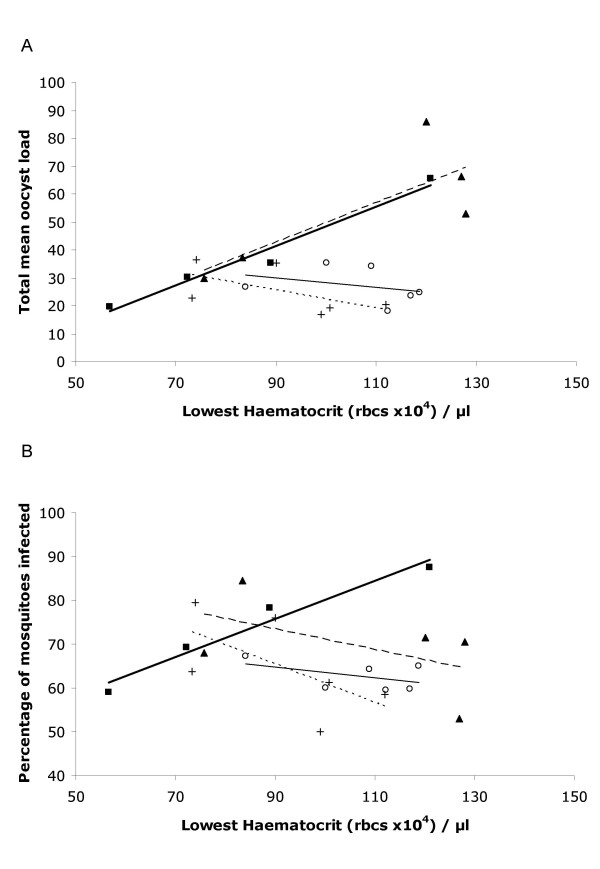
Comparison of lifetime transmission success with peak anaemia. Lifetime transmission success is defined as (A) the mean number of oocysts per mosquito for a given day totalled over the 4 days of acute phase transmission; (B) the percentage of mosquitoes with at least one oocyst. Infections were initiated using infectious mosquitoes as in Figs. 3, 4 & 6. Thai or SL clone alone, 8 infective mosquitoes per bird; Mixed infections were initiated using 8 or 4 infective mosquitoes from batches of mosquitoes infected with either of the clones. Mosquitoes were gorged on all birds from the first day parasites were patent in the blood. Individuals that died before completion of the transmission period are excluded (a) Thai clone (square – thin solid line); SL clone (open circles – thick solid line); mixed 8+8 clones (triangle – long dotted line); mixed 4+4 clones (crosses – short dotted line). Lines are least squared residual best fit.